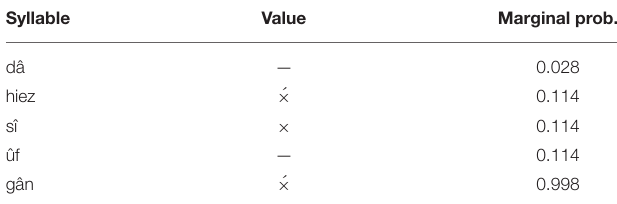
TABLE 7 | Example (7), average probability